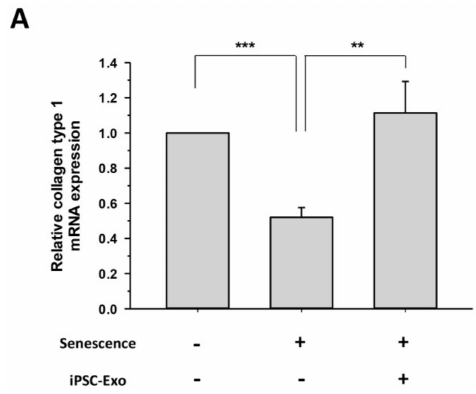
Figure 6. Effect of iPSC-Exo on the expression of SA- β -Gal in senescent HDFs. The passage numbers of control and senescent HDFs were 5 and 31, respectively. ( A ) SA- β -Gal-positive cells were shown in blue when observed under optical microscopy. ( B ) According to the standard shown in the figure, cells were classified into three categories: unstained, weak, and strong, and the number of cells in each group was expressed as a percentage. * p < 0.05, ** p < 0.01 compared to the iPSC-Exo-untreated senescent group. Statistical analysis was performed with three different